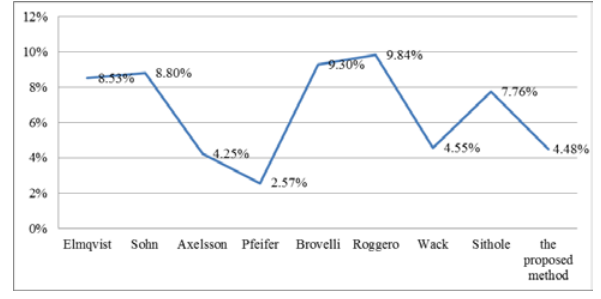
Figure 4. Total error